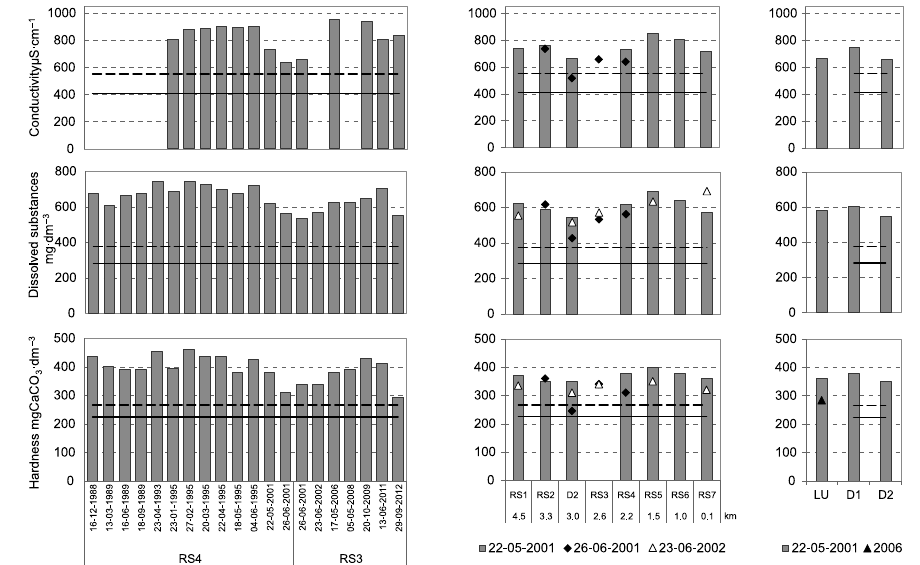
Fig. 9. General indicators of water salinity: conductivity, dissolved substances and